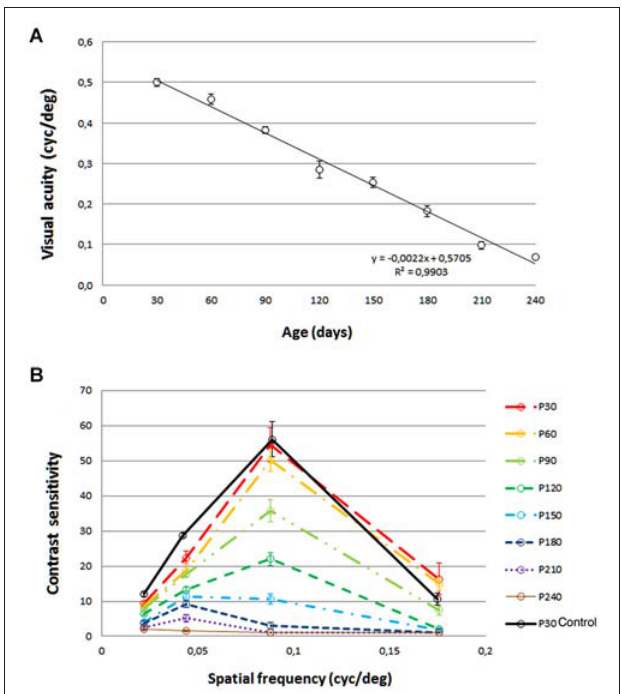
to only 34% of the corresponding value in wild-type LExSD rats aged P29 (604 ± 45 µ V). Despite being affected at early time points, a-waves from pigmented P23H rats could ( Figure 2A